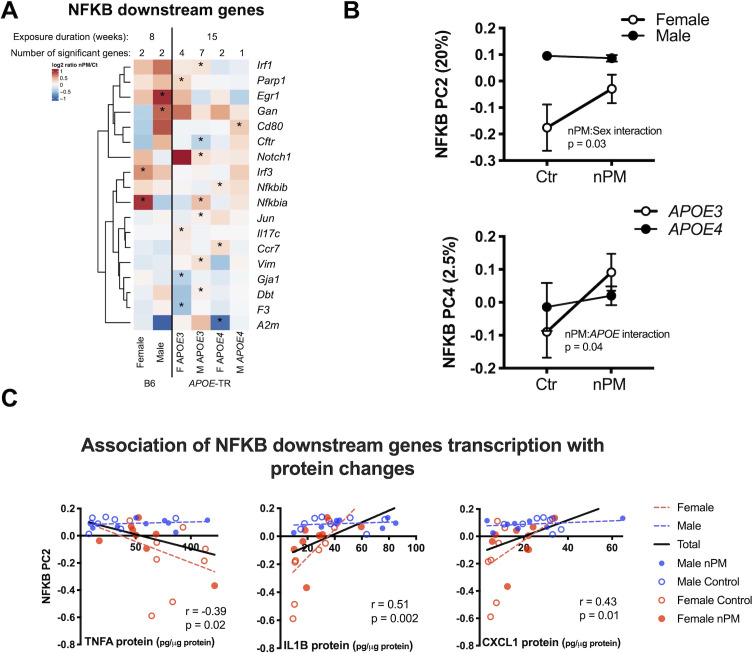
nPM induced inflammatory responses with sex- and APOE specificity.(A) Stratified analysis of NFKB downstream genes responses to nPM. The combined IPA datasets included 133 NFKB downstream genes. (B) Principal component analysis of 133 NFKB downstream genes in APOE-TR: PC2 (20% of total variance) was associated with nPM: sex interaction; PC4 (2.5% of variance), associated with nPM:APOE interaction. (C) Protein levels of genes downstream of NFKB were correlated with PC2: positive correlations for CXCL1 and IL1B; inverse correlation with TNFA. Only females responded to nPM. Sample size of 4/genotype/sex/treatment.